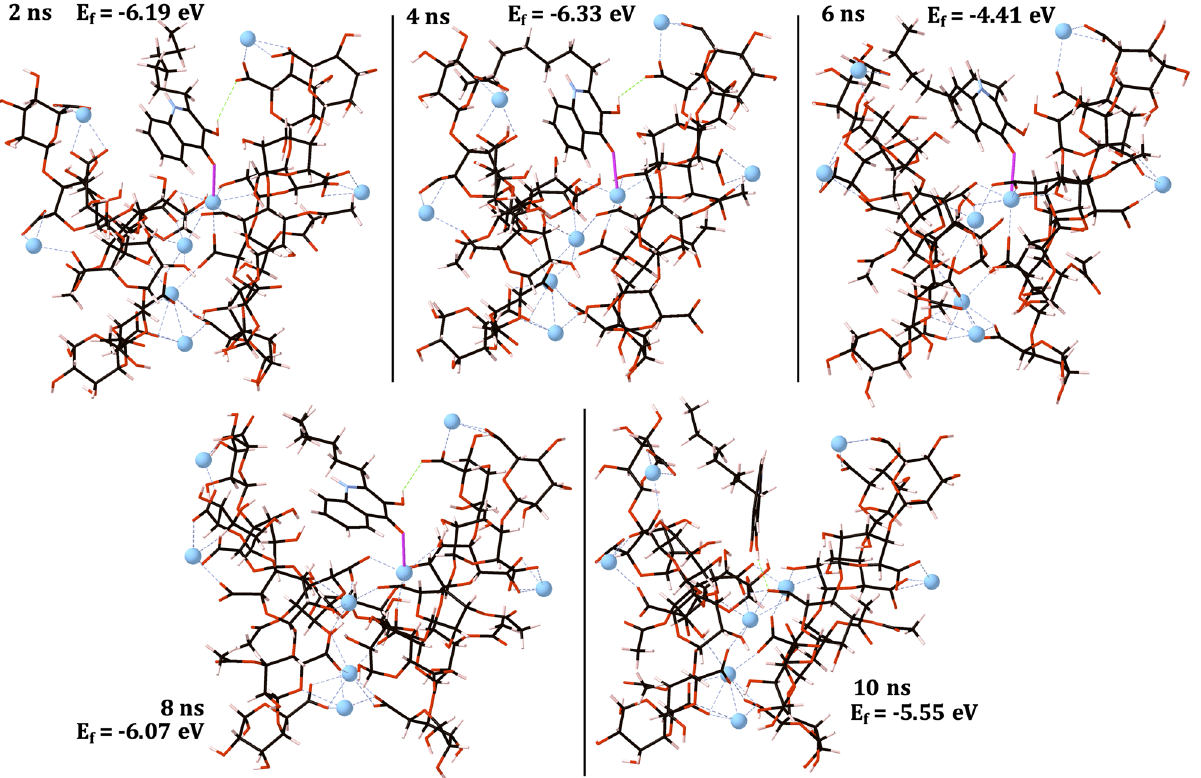
Figure 5. EPS-PQS structures and their formation energies (eV) displayed at 2 ns intervals. Carbon atoms are shown in grey, oxygen in red, calcium in blue and hydrogen in pink. Calcium–oxygen ionic bonds are shown with dashed blue lines and hydrogen bonds are shown with dashed green lines. Ionic bonds between the PQS and 4-PolyMG MD system are shown with bold pink